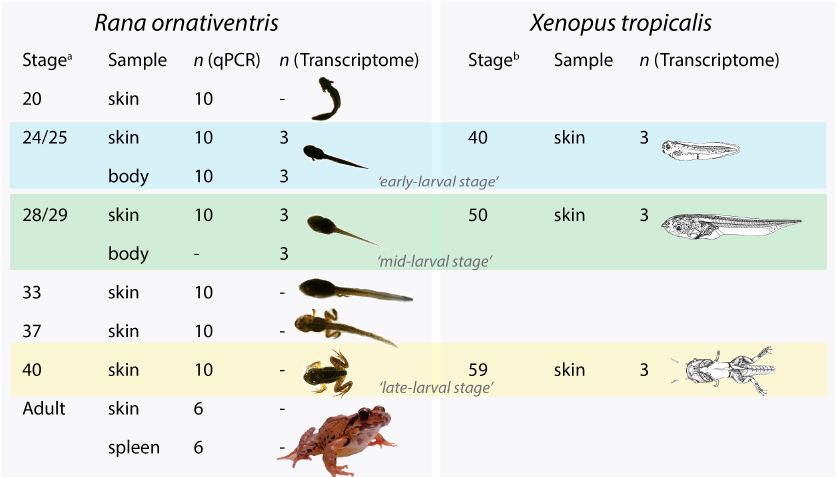
Figure 1. Overview of Rana ornativentris and Xenopus tropicalis samples used for qPCR and transcriptome analyses in this study. a R. ornativentris stage approximations based on Tahara [19,20]. b X. tropicalis stage approximations based on Nieuwkoop and Faber [23]. Full stage approximations in Table S1. Images of frogs in all figures are not to scale (source: Q. Lau for R. ornativentris , Nieuwkoop and Faber (1994) via Xenbase for X. tropicalis ).